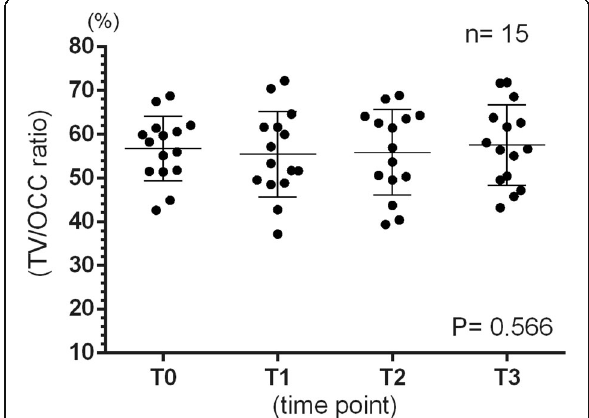
Fig. 7 The TV/OCC ratio of all subjects. The mean ± S.D. of TV/OCC ratio was 56.75 ± 7.43% at T0, 55.41 ± 9.80% at T1, 55.84 ± 9.83% at T2, and 57.50 ± 9.21% at T3. Repeated one-way ANOVA and Geisser- Greenhouse correction were assessed, and no significant difference was observed among the four time points ( P = 0.566)